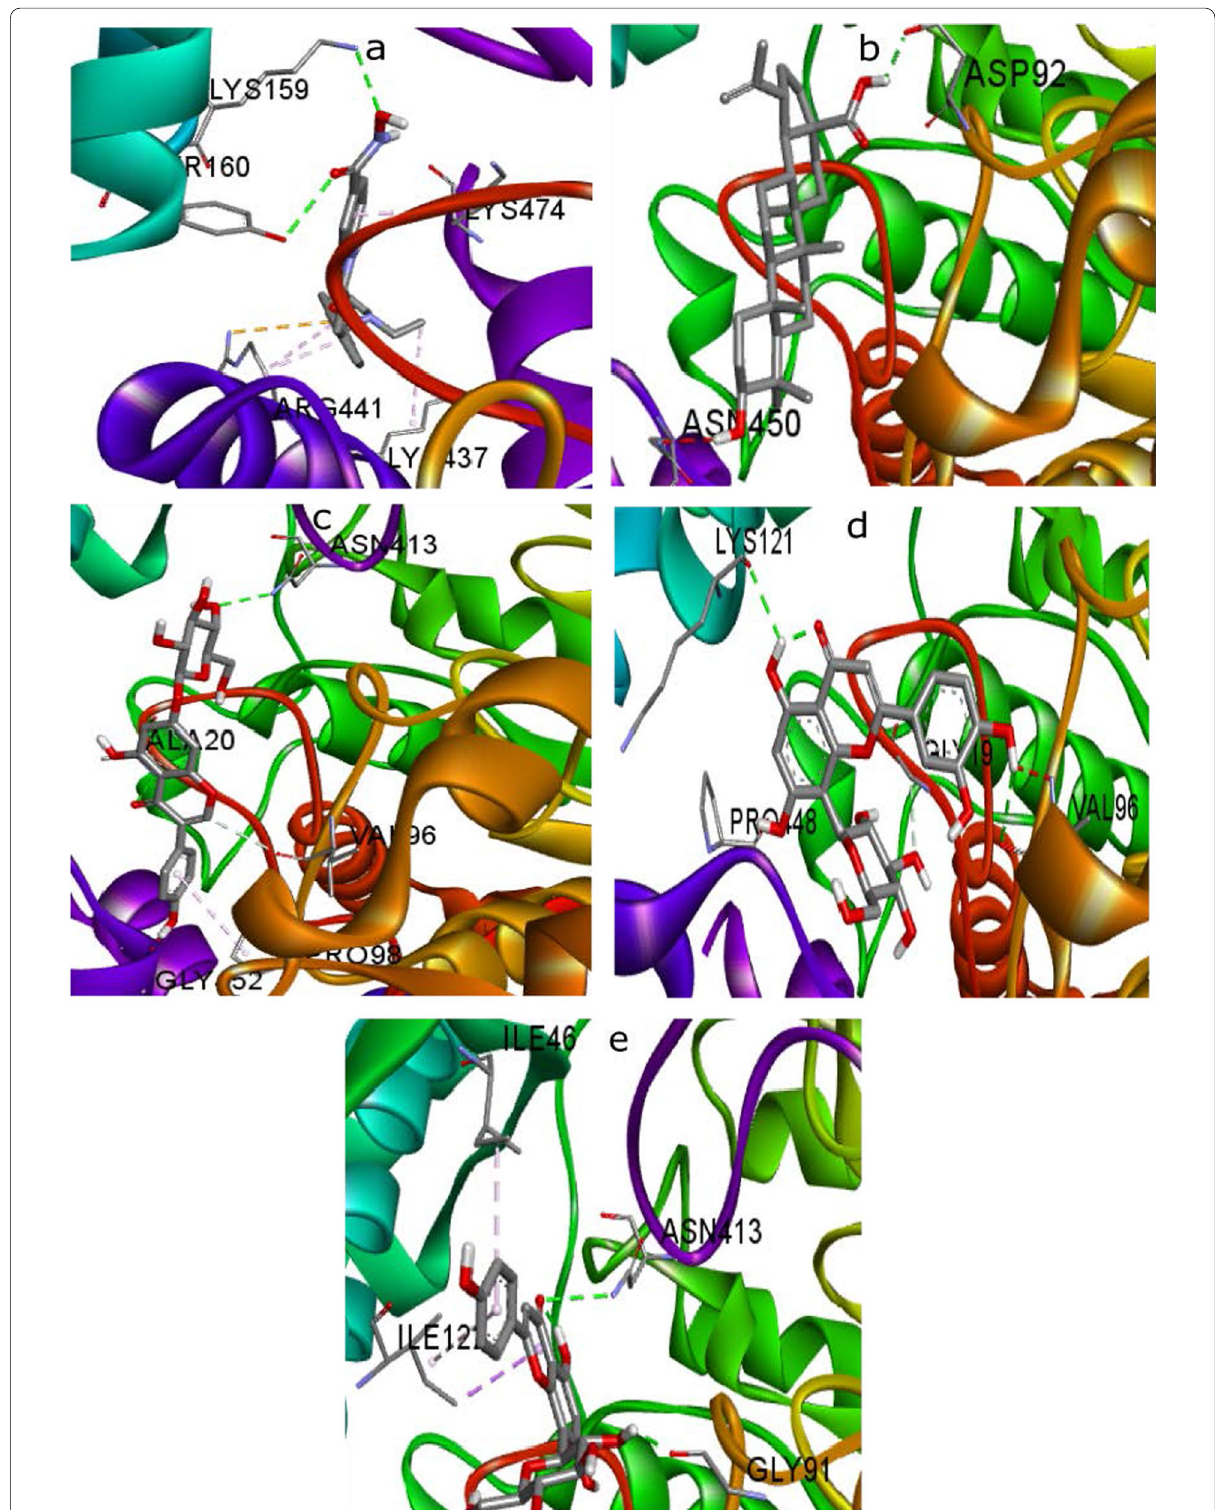
Fig. 3 3D view of the interaction between a givinostat b betulinic acid c genistin d orientin e vitexin and the binding sites in histone deacetylase